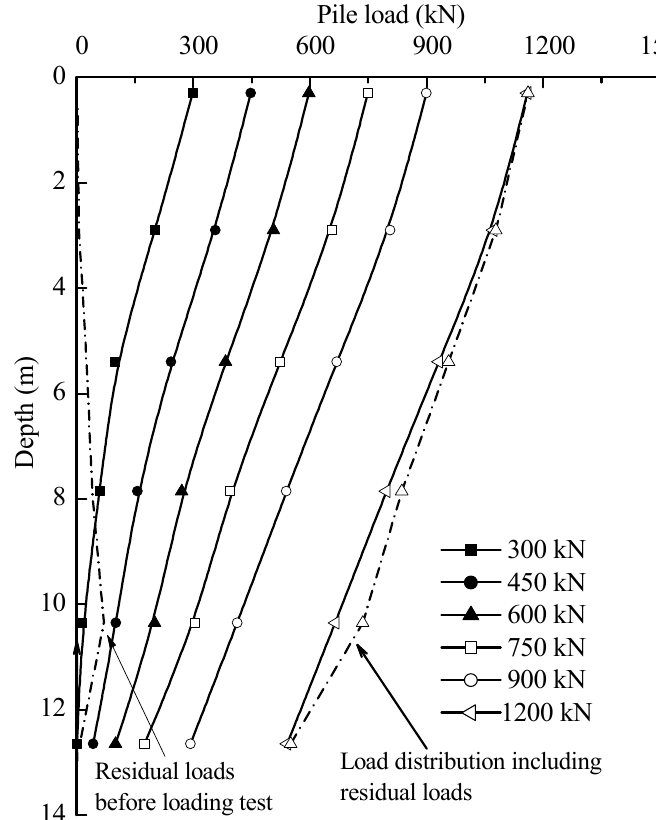
Figure 14. Load distribution curves for test pile.